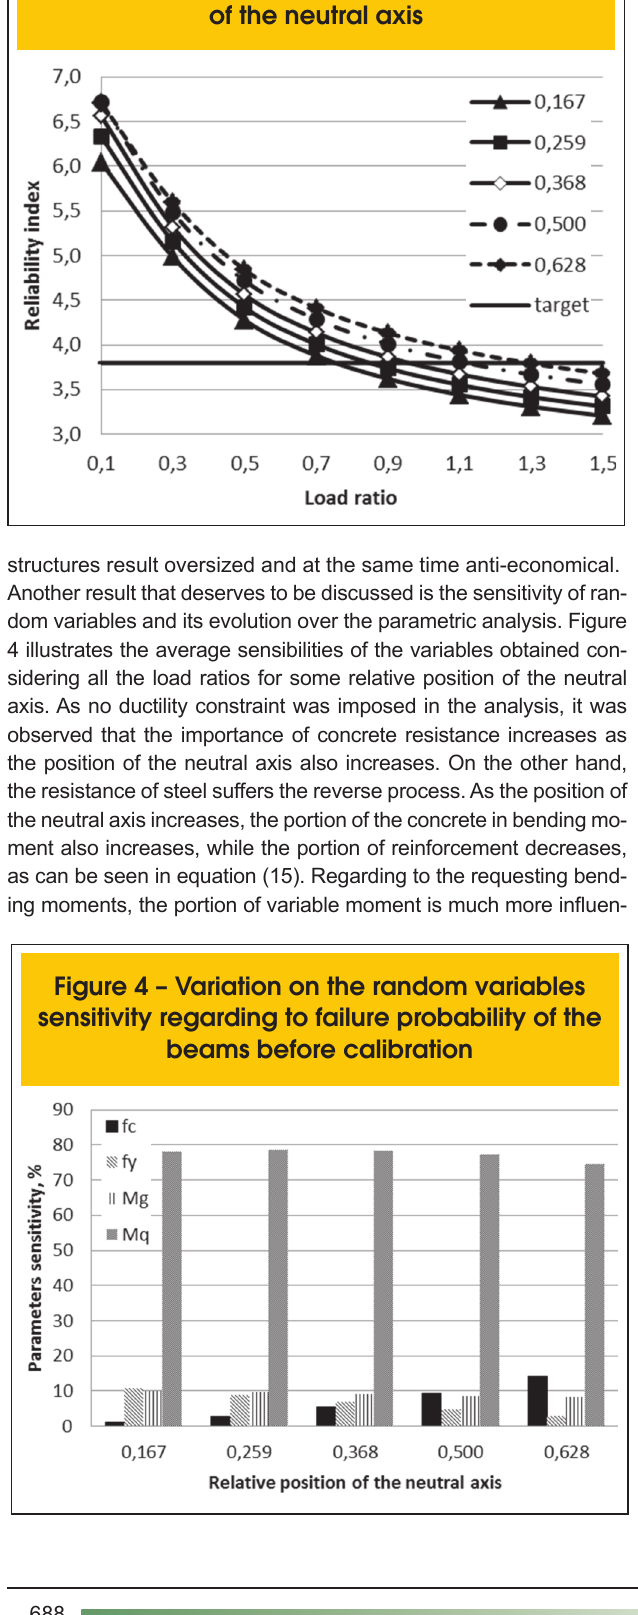
Figure 3 – Variation of the reliability index in function of the load ratio and relative position